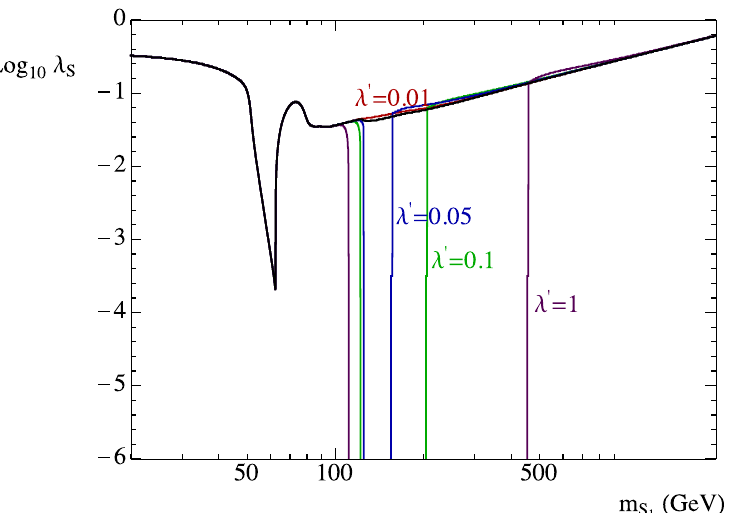
Figure 10 . Contour lines of the correct relic DM abundance in an SHP effective theory consisting of the usual SHP Lagrangian plus an extra operator, as given in eq. (4.2), for several values of the λ ′ coupling. This effective theory describes the ESHP in large regions of the parameter